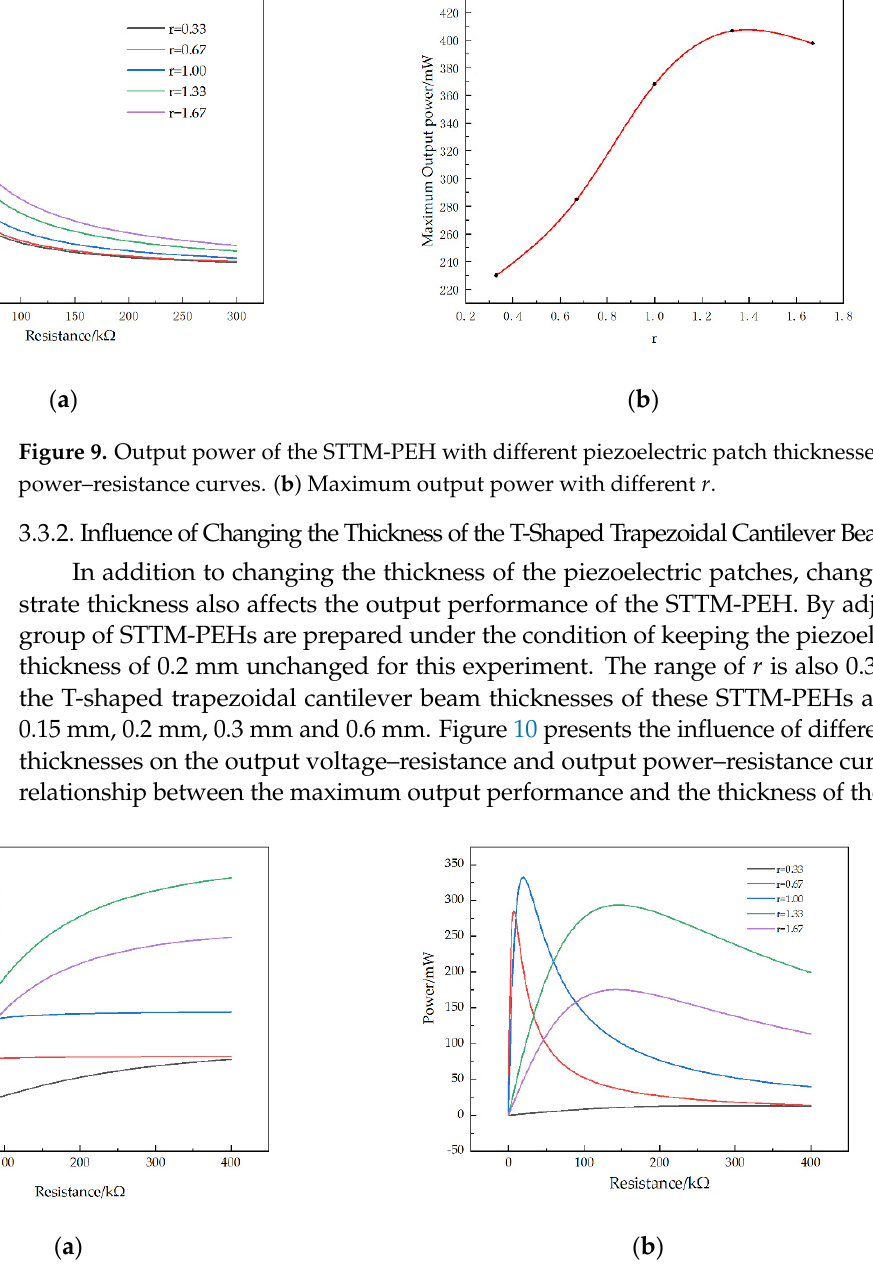
( b ) Figure 8. Output voltage of the STTM-PEH with different piezoelectric patch thicknesses. ( a ) Output voltage–resistance curves. ( b ) Maximum output voltage with different 𝑟 . Figure 9a shows that the output power–resistance curve falls more slowly with an increase in 𝑟 . This means that the STTM-PEH with thicker piezoelectric patches can gen- erate higher output power in the descent zone of its output power–resistance curve with identical external resistance. Hence, thicker piezoelectric patches should be selected for higher output power when the external resistance is greater than 50 kΩ . Moreover, in con- trast to the variation in the maximum output voltage, the maximum output power in-